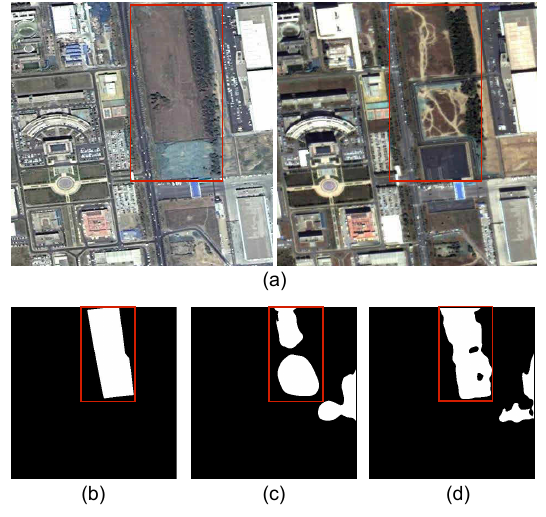
Figure 6. Visualization of the function for the skip connection. ( a ) the optical remote sensing image pair. ( b ) The label mask. ( c ) The result without skip connection. ( d ) The result with skip connection. Coarse label: The influence of the downsampling of the ground truths for our network is further tested. In our ablation study, the Coarse Label setting represents that we down- sample the ground truths during the training procedure. We further test the results when we up-sample the network output to the size of 480 × 480 to conduct the back-propagation. The experimental results are shown in Table